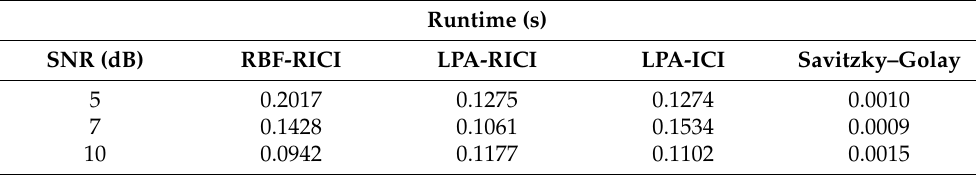
Table 28. HeaviSine signal—Filtering algorithms’ runtimes.